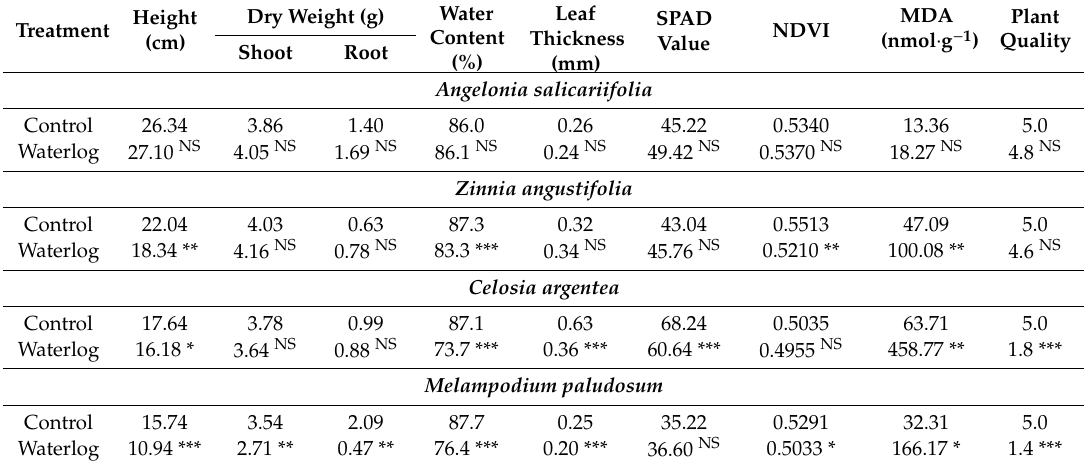
Table 1. E ff ects of 10 days of waterlogging on plant growth, physiological index and quality of Angelonia salicariifolia , Zinnia angustifolia , Celosia argentea and Melampodium paludosum . Height Treatment